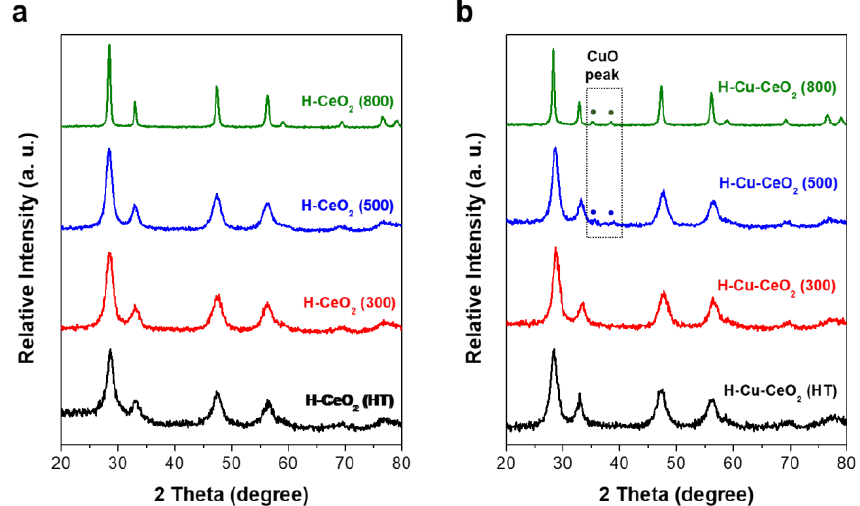
Figure 3. XRD pattern of ( a ) the H-CeO 2 support and ( b ) the H-Cu-CeO 2